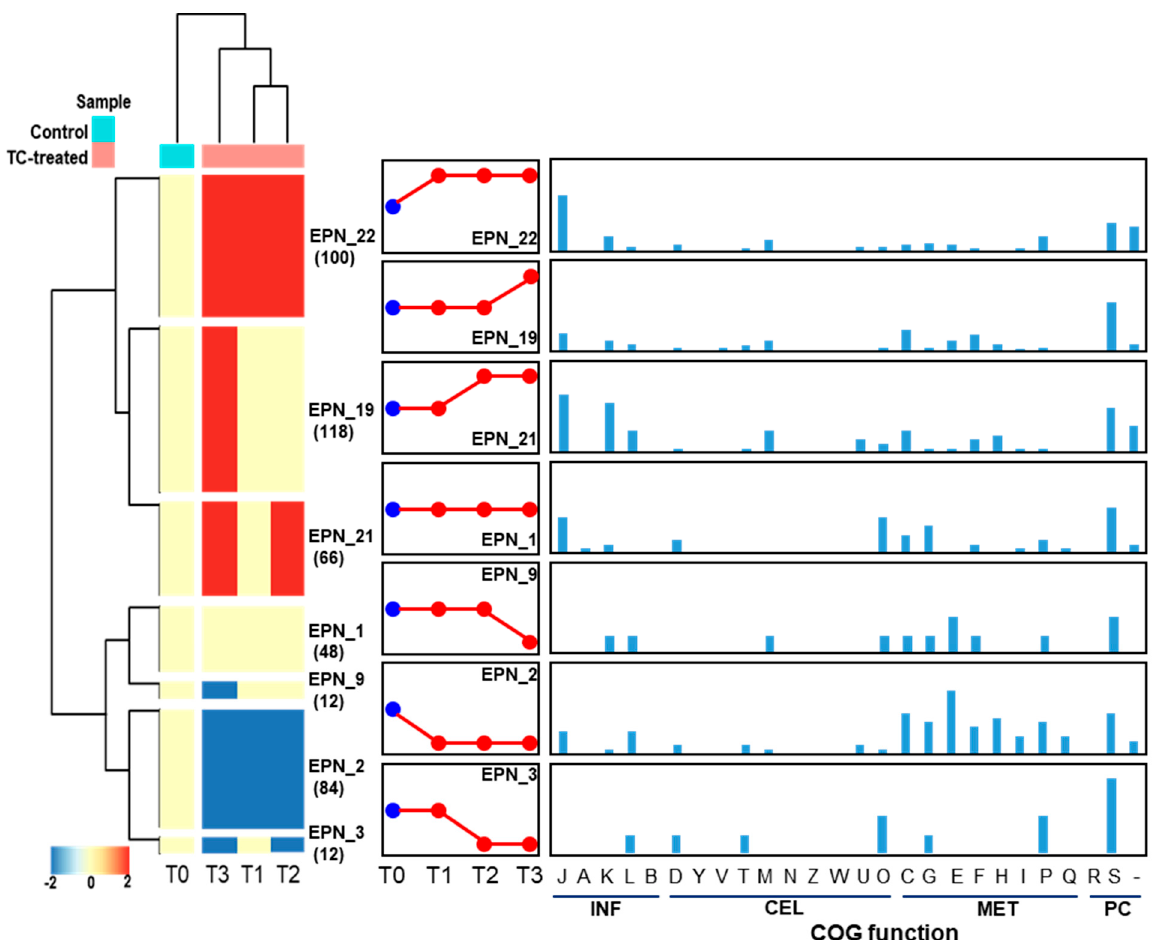
Figure 12. Protein expression patterns and functional distribution of proteins showing TC-dependent expression changes. INF, information storage and processing; CEL, cellular processes and signaling; MET, metabolism; PC, poorly characterized. COG functional categories: J, translation, ribosomal structure, and biogenesis; A, RNA processing and modification; K, transcription; L, replication, recombination, and repair; B, chromatin structure and dynamics; D, cell cycle control, cell division, chromosome partitioning; Y, nuclear structure; V, defense mechanisms; T, signal transduction mechanisms; M, cell wall/membrane/envelope biogenesis; N, cell motility; Z, cytoskeleton; W, extracellular structures; U, intracellular trafficking, secretion, and vesicular transport; O, posttranslational modification, protein turnover, chaperones; C, energy production and conversion; G, carbohydrate transport and metabolism; E, amino acid transport and metabolism; F, nucleotide transport and metabolism; H, coenzyme transport and metabolism; I, lipid transport and metabolism; P, inorganic ion transport and metabolism; Q, secondary metabolite biosynthesis, transport, and catabolism; R, general function prediction only; S, function unknown.